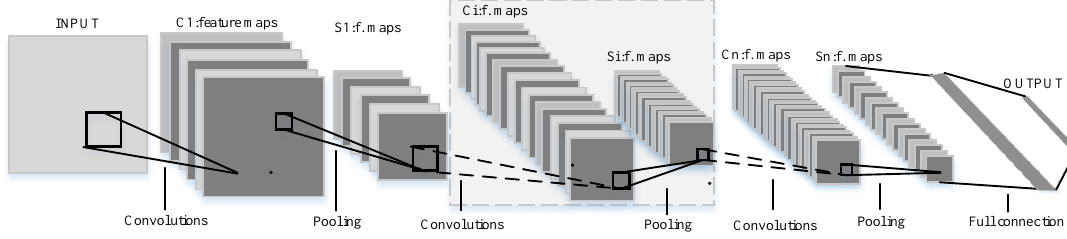
Figure 8. Schematic diagram of the convolutional neural network (CNN).